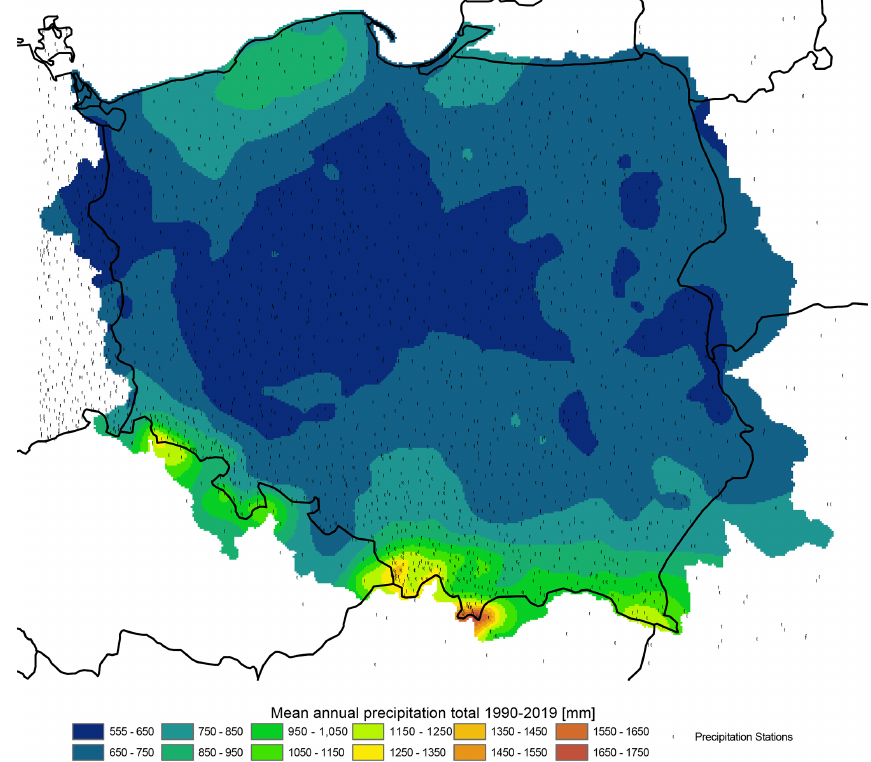
Figure 22. Mean annual precipitation in the time period 1990–2019: output from the G2DC-PL +